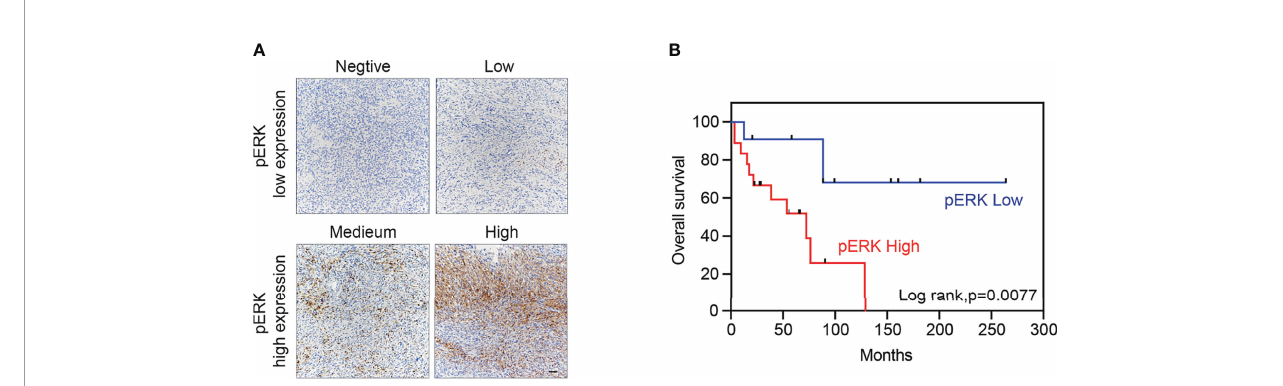
FIGURE 1 | High expression of p-ERK correlates with dismal prognosis in MPNSTs. (A) Typical images of p-ERK in MPNST tissues following immunohistochemical staining, scored as 0 (negative), 1 (low positive), 2 (medium positive), and 3 (high positive). Scale bar = 50 m m (B) Kaplan – Meier curves for cumulative survival according to the p-ERK level in the MPNST cohort with available follow-up data (n = 29, p = 0.007 by the log-rank test). Negative and low positive were de fi ned as low expression, while medium and high positive were de fi ned as high